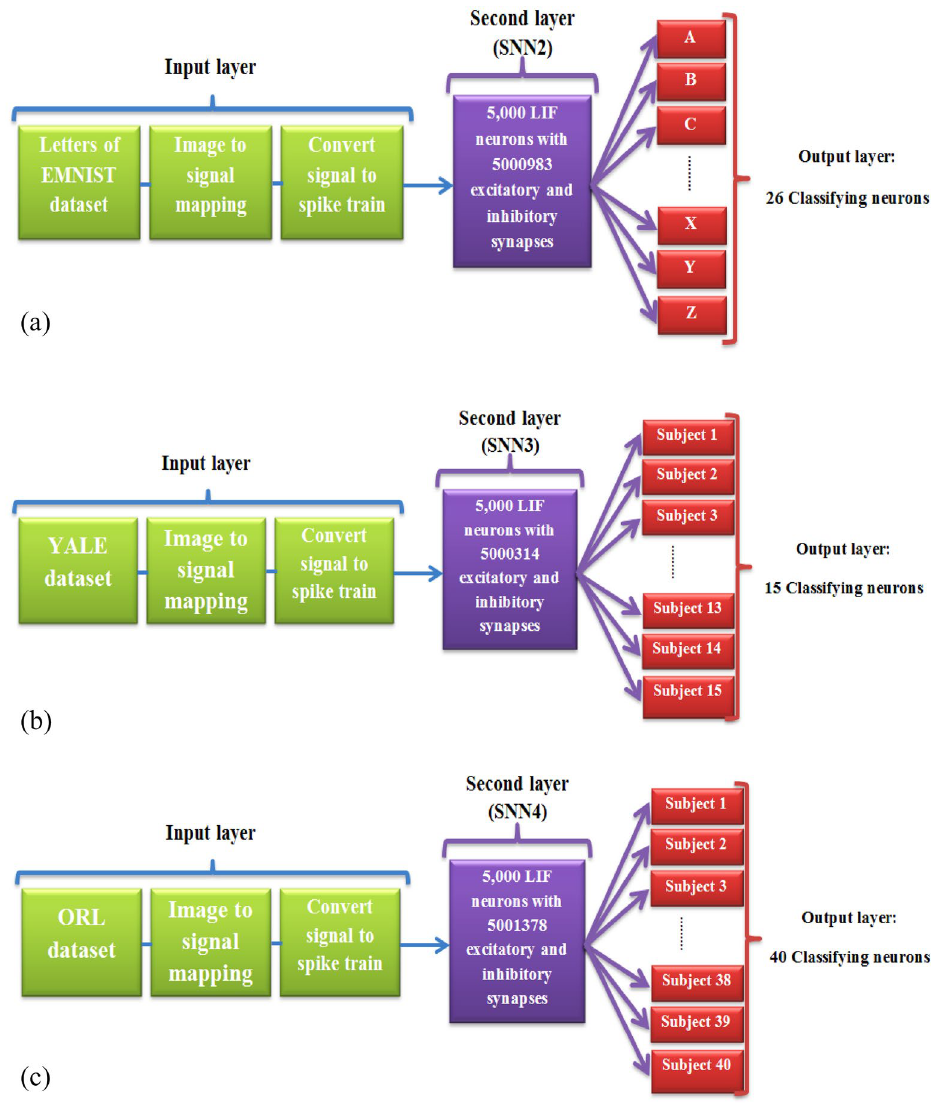
Figure 5. ( a )–( c ) are the general schematic of the proposed configurations as the pattern recognition platforms based on SNN2, SNN3, and SNN4.